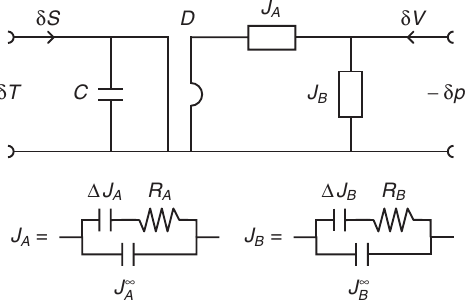
FIG. 7. Electrical equivalent diagram of the interaction of a volume element with its surroundings through two gates. The thermal gate where entropy displacement (cid:5)S or temperature (cid:5)T can be controlled, and the mechanical gate where volume displacement (cid:5)V or pressure (cid:5)p can be controlled. (cid:5)S and (cid:5)V are generalized charge displacements and (cid:5)T and (cid:2) (cid:5)p are generalized voltages. The relaxational elements J simple single-relaxation-time